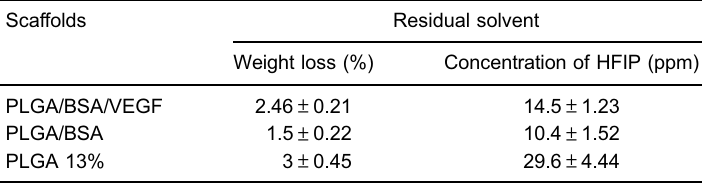
Table 2. Average quantity of residual solvent in the various scaffolds